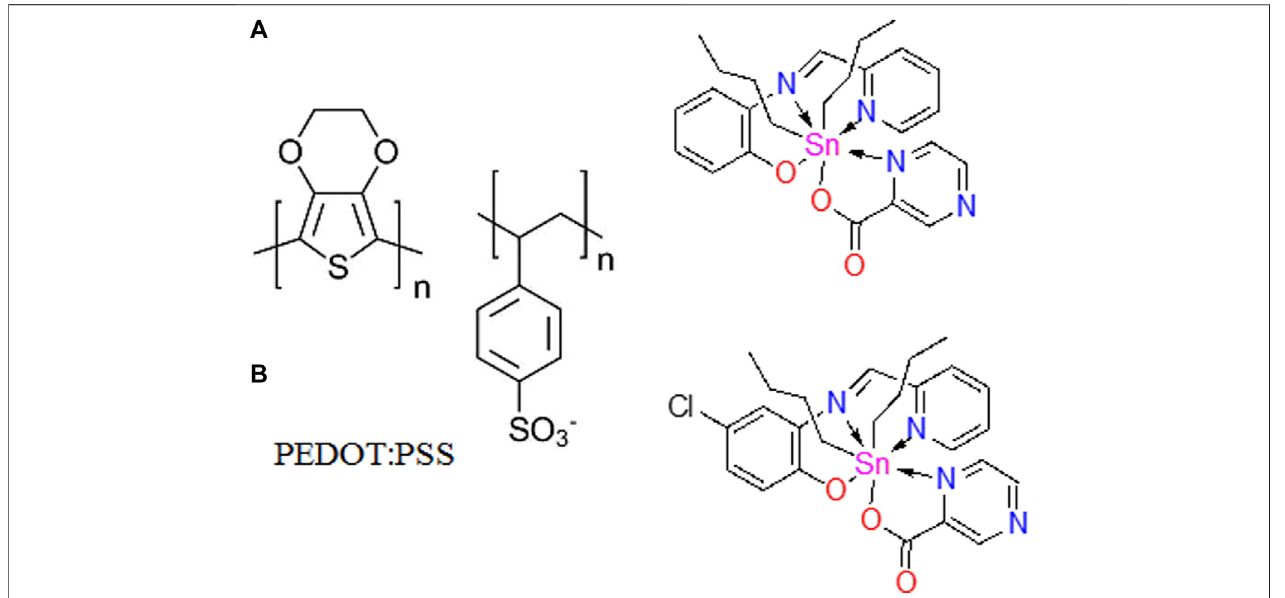
FIGURE 1 | Structures of PEDOT:PSS and heptacoordinated organotin (IV) complexes (A) without the substituent and (B) with the chloride substituent.